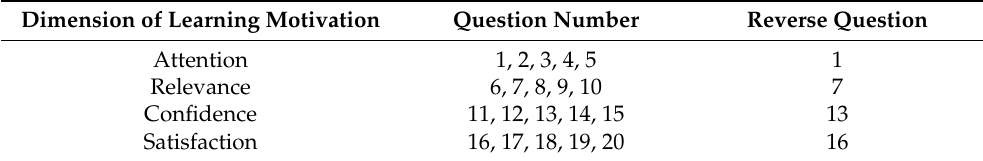
Table 1. Distribution of ARCS questionnaire questions. Dimension of Learning Motivation Question Number Reverse Question Attention 1, 2, 3, 4, 5 1 Relevance 6, 7, 8, 9, 10 7 Confidence 11, 12, 13, 14, 15 13 Satisfaction 16, 17, 18, 19, 20